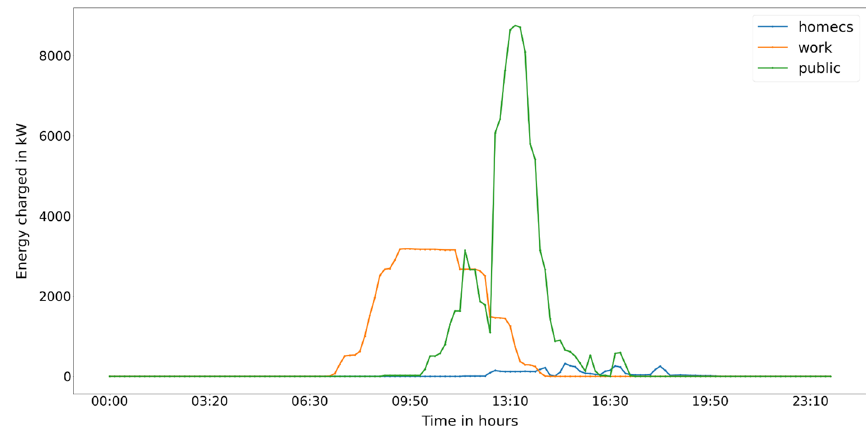
Fig. 13 Aggregated home, work, and public power profiles, here scenario